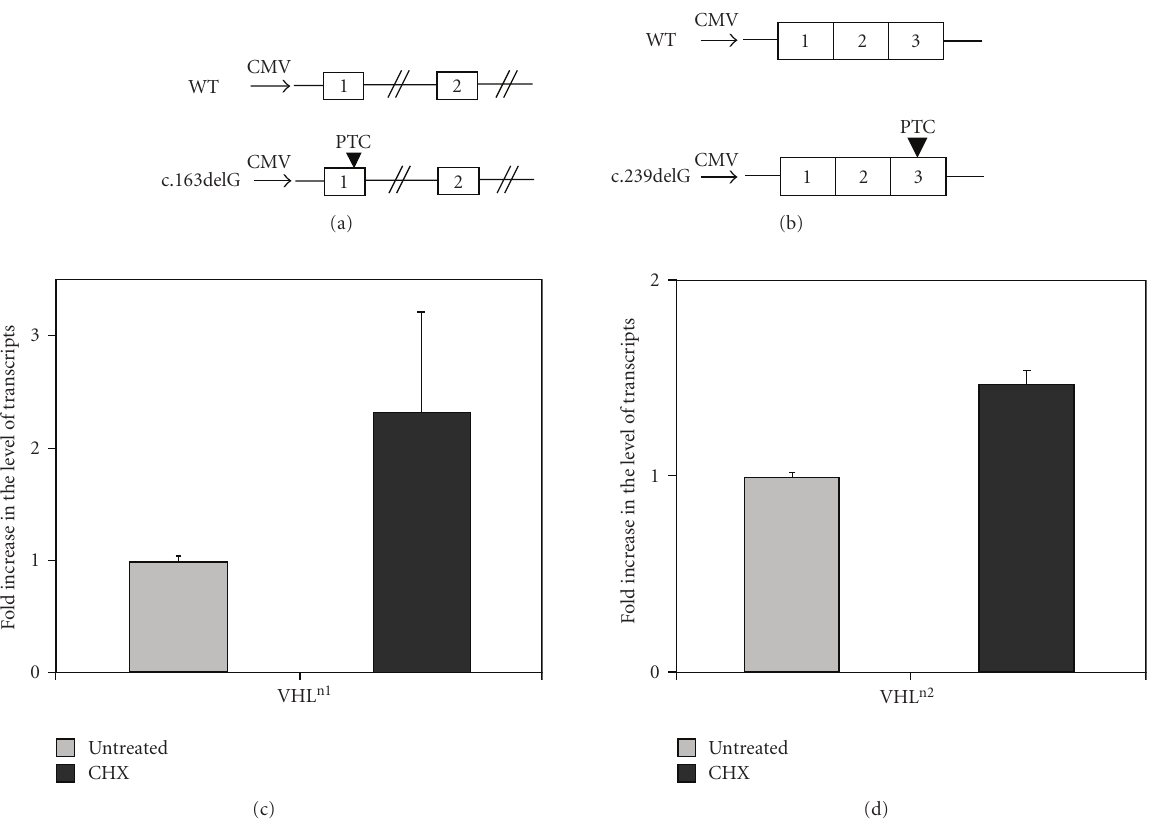
Figure 3: E ff ect of CHX treatment on the level of the c.163delG and c.239delG VHL mRNA. (a) Scheme of the WT (upper panel) and c.163delG constructs, which contained the exons 1-2 (marked in the boxes by numbers), a part of the intronic sequence between exons 1-2 and a piece of intron downstream the exon 2. The CMV promoter is marked by a thick horizontal arrow. (b) Scheme of the WT and c.239delG construct containing the entire coding sequence of the VHL gene. (c) and (d) QPCR analysis of VHL transcripts before and following CHX treatment. The level of mRNA transcribed from VHL construct carrying either the wild type sequence or the c.163delG and c.239delG mutations was normalized to the mRNA level of GFP. The ratio between these normalized levels following CHX treatment was calculated and compared with the ratio in untreated cells. The fold increase in the level of VHL c.163delG and c.239delG transcripts is shown as mean ±